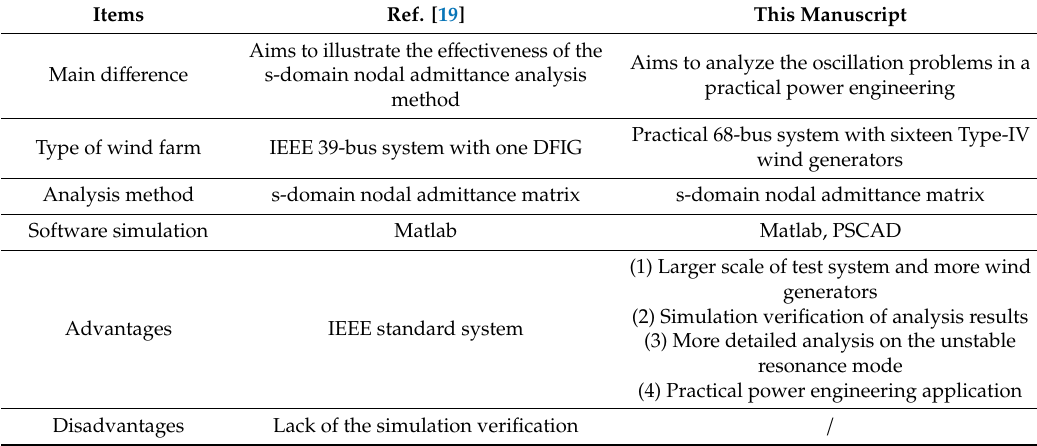
Table 1. Comparison between case studies in both Ref. [19] and this manuscript.